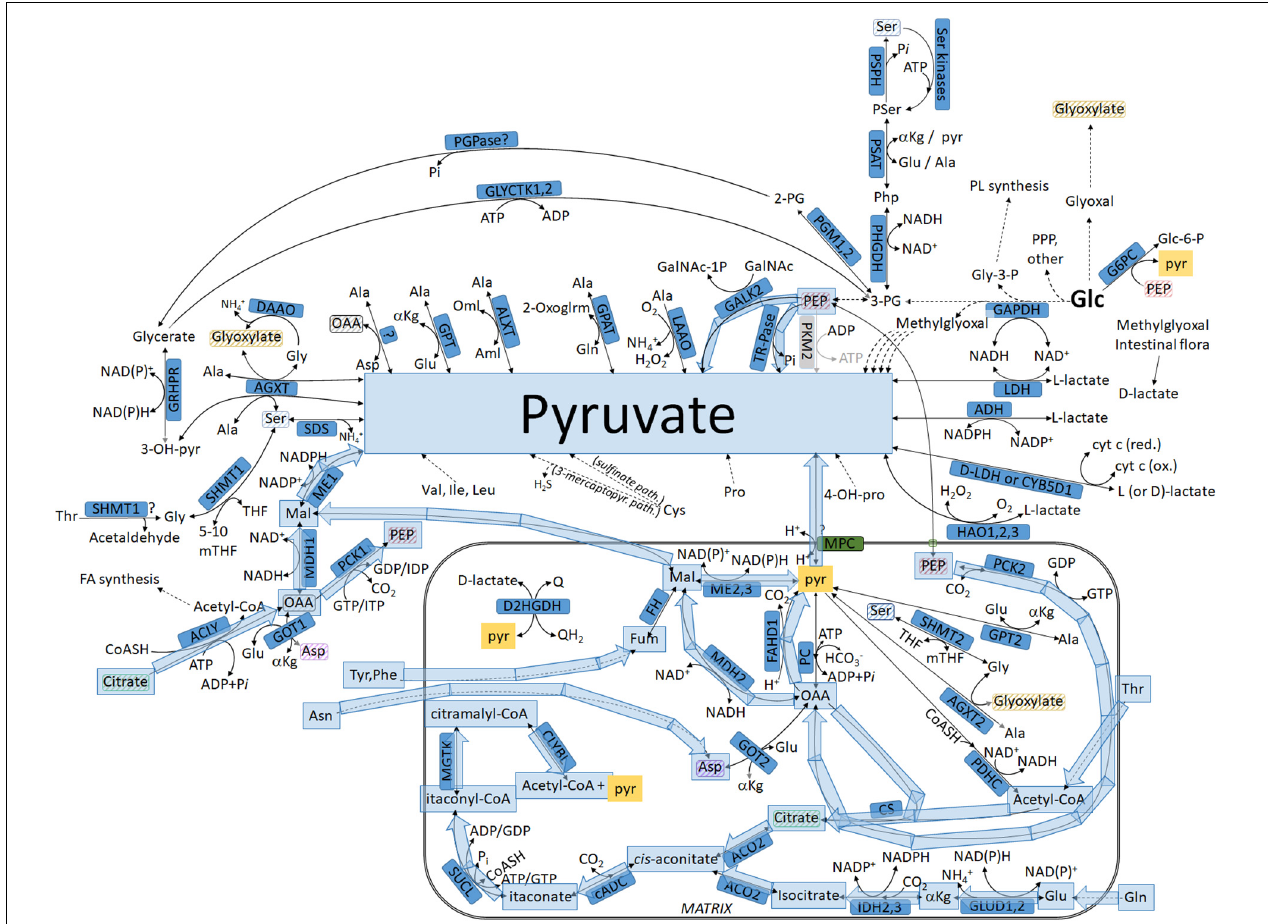
FIGURE 5 | Pathways leading to pyruvate but not commencing from glucose, highlighted in blue: intermediates transiting through the mitochondria. For abbreviations, see Table 1 .